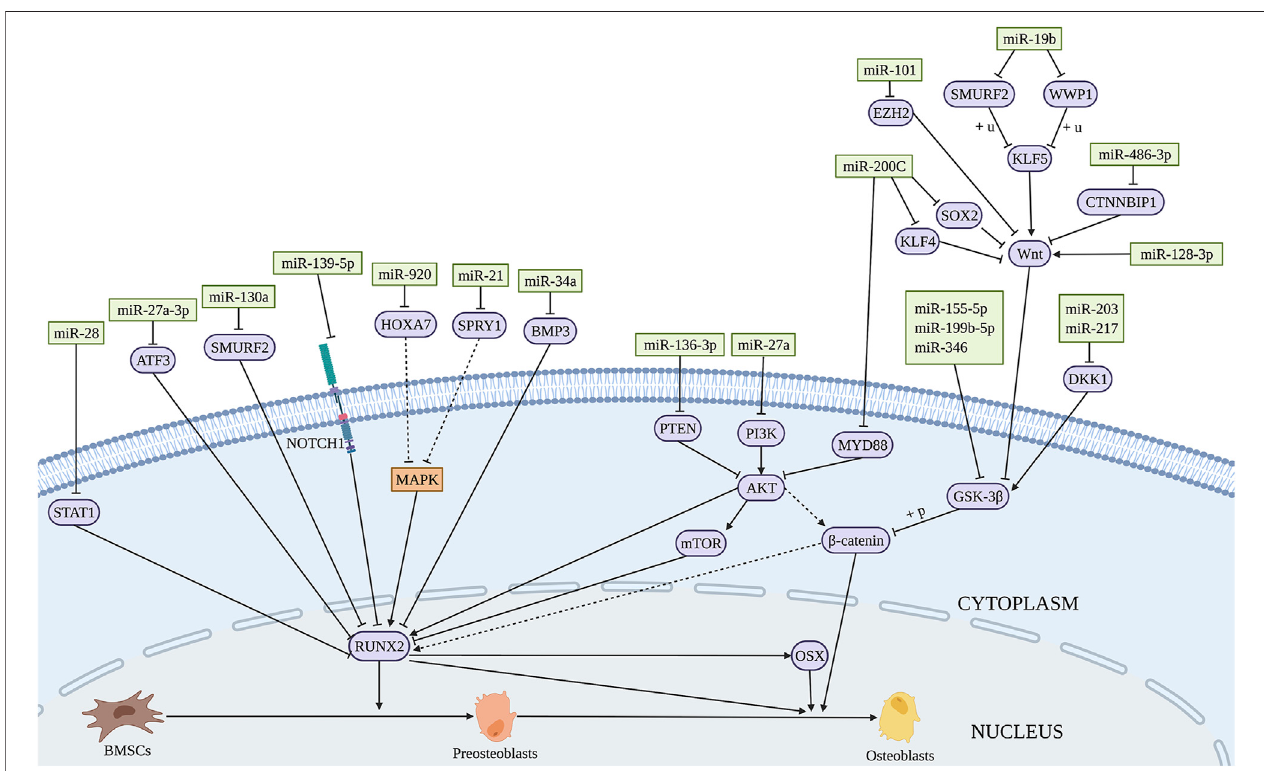
FIGURE 2 | Illustration of the role and regulatory mechanism of miRNAs-induced osteogenic differentiation of BMSCs. Several miRNAs promote osteogenic differentiation of BMSCs by regulating the expression of target genes and related signaling pathways. (Created with BioRender.com).